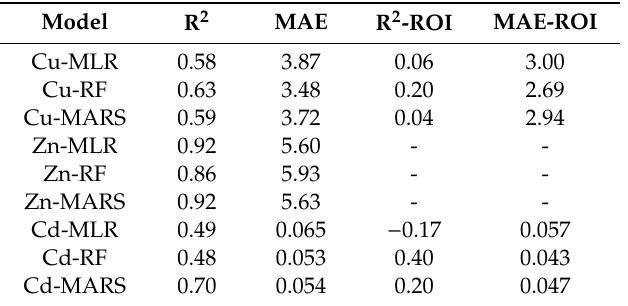
Table 4. Validation statistics from the cross-validation of the multiple linear regression (MLR), random forest regression (RF), and multivariate adaptive regression spline (MARS) models for copper (Cu), zinc (Zn), and cadmium (Cd). R 2 = coe ffi cient of determination; MAE = mean absolute error (mg kg − 1